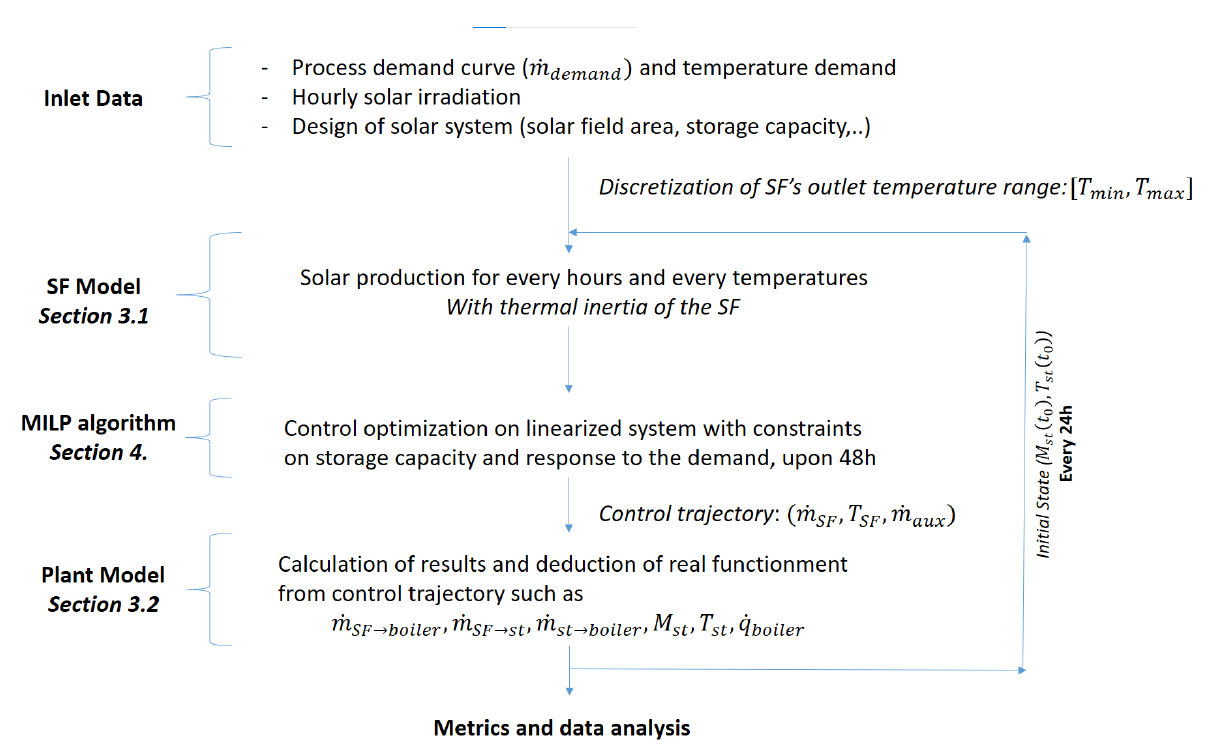
Figure 2. Schematic approach to control optimization .